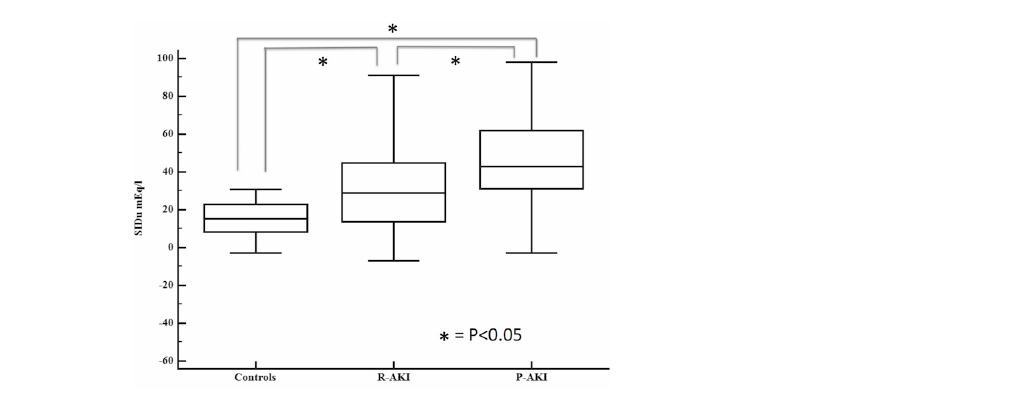
Fig 1. Boxplot representation of day-0 urinary Strong Ion Difference values across the three groups.